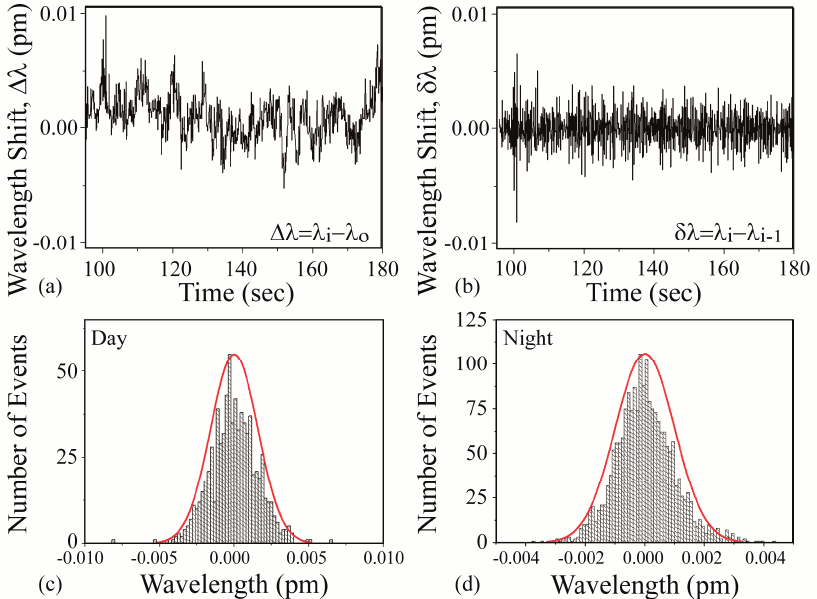
Figure 4. Noise measurements. ( a ) Normalized resonant wavelength shift ( Δλ ) measured during the day; ( b ) instantaneous resonant wavelength shift ( δλ ) of part (a); ( c ) histogram of the values in part (b); ( d ) histogram of values of an instantaneous resonant wavelength shift ( δλ ) measured at